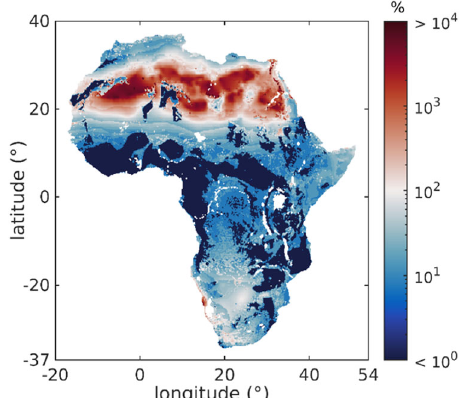
Fig. 7 Percentage of the exploitable recharge that would be extracted by 50 PVWPS of most ef fi cient capacity. Red pixels indicate that the extraction exceeds the exploitable recharge and blue pixels that it does not.